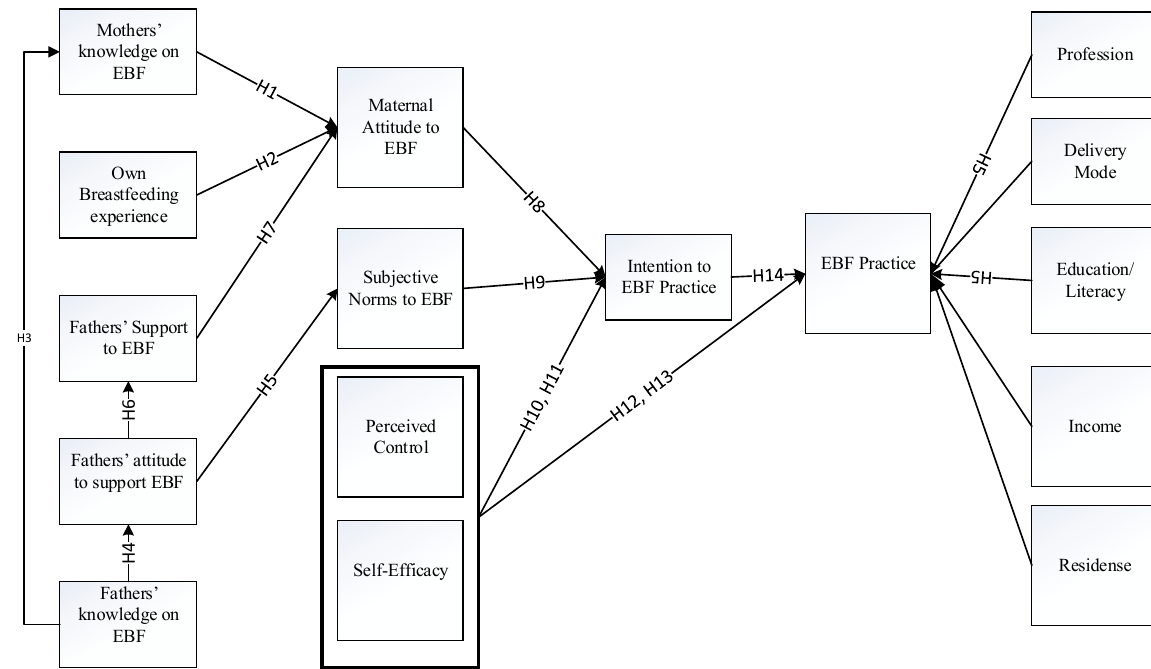
Figure 1. Father’s knowledge and attitude towards mothers’ practice of exclusive breastfeeding (EBF): the theoretical relationship in accordance with the theory of planned behavior (TPB).